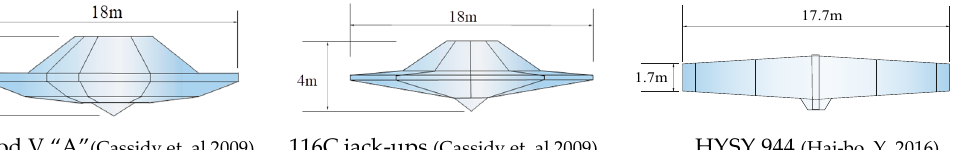
Figure 2. Three typical spudcans[3,12].